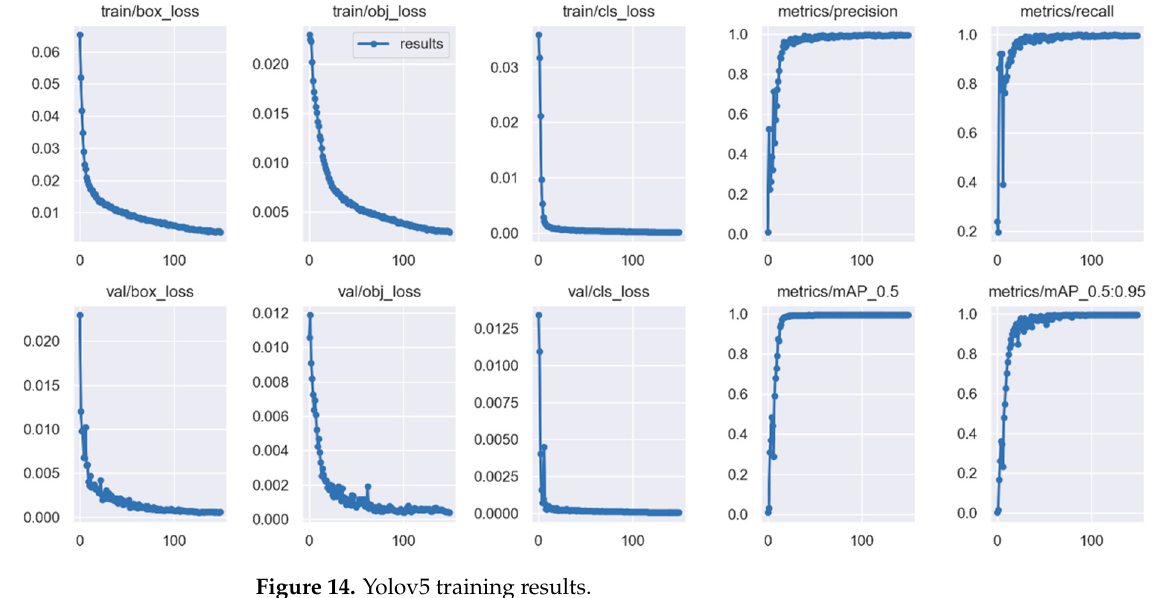
Figure 14. Yolov5 training results.